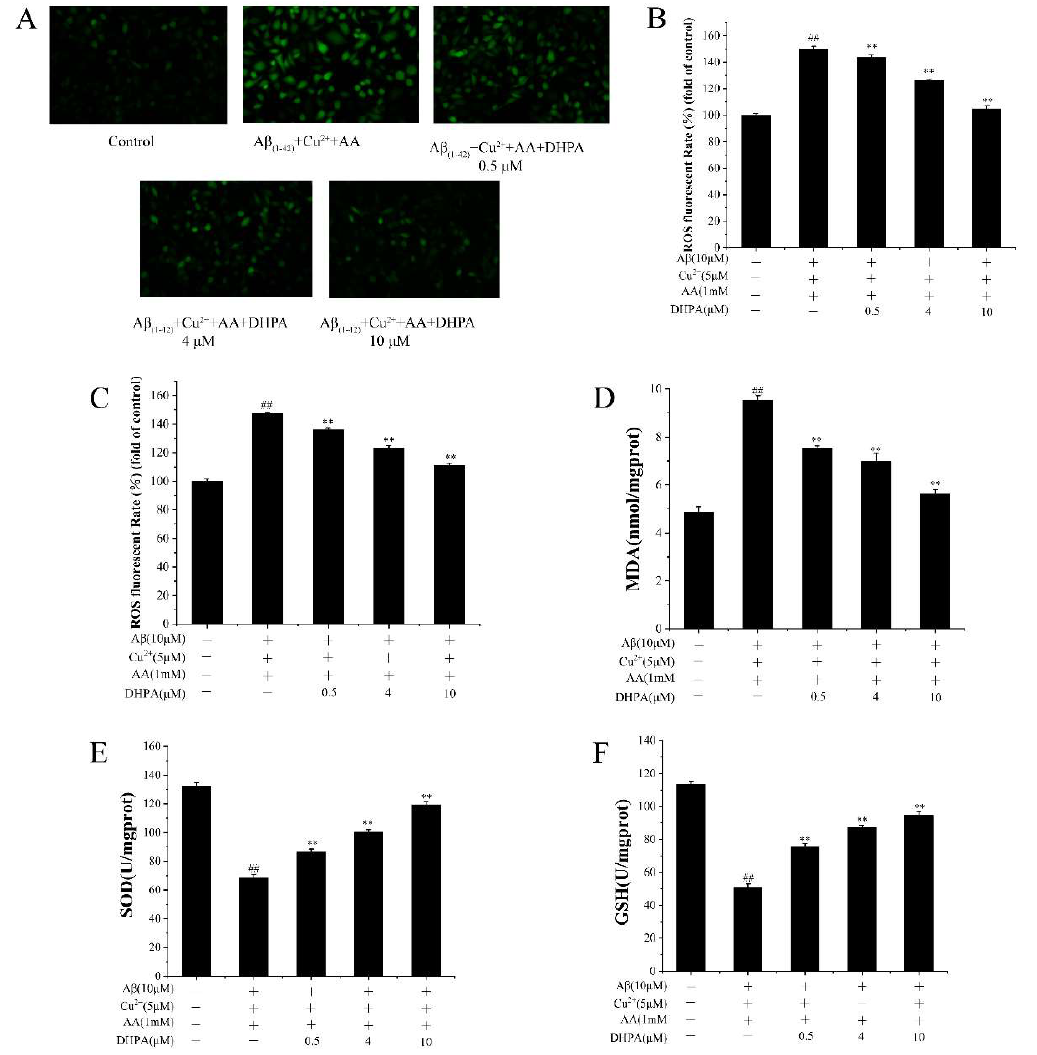
Figure 4. The effects of DHPA on the related antioxidant indices in SH-SY5Y cells. Intracellular ROS fluorescence images ( A ), intracellular ROS production ( B , C ), the content of MDA ( D ), and the activities of SOD ( E ) and GSH ( F ). For ( C ), the cells were pre-treated with Aβ/Cu 2+ /AA for 6 h, and washed afterward, with different concentrations of DHPA added. For the other experiments, Aβ/Cu 2+ /AA and DHPA were mixed for cell incubation. ## p < 0.01 compared to the control group, * p < 0.05 and ** p < 0.01 compared to the Aβ/Cu 2+ /AA-treated group.